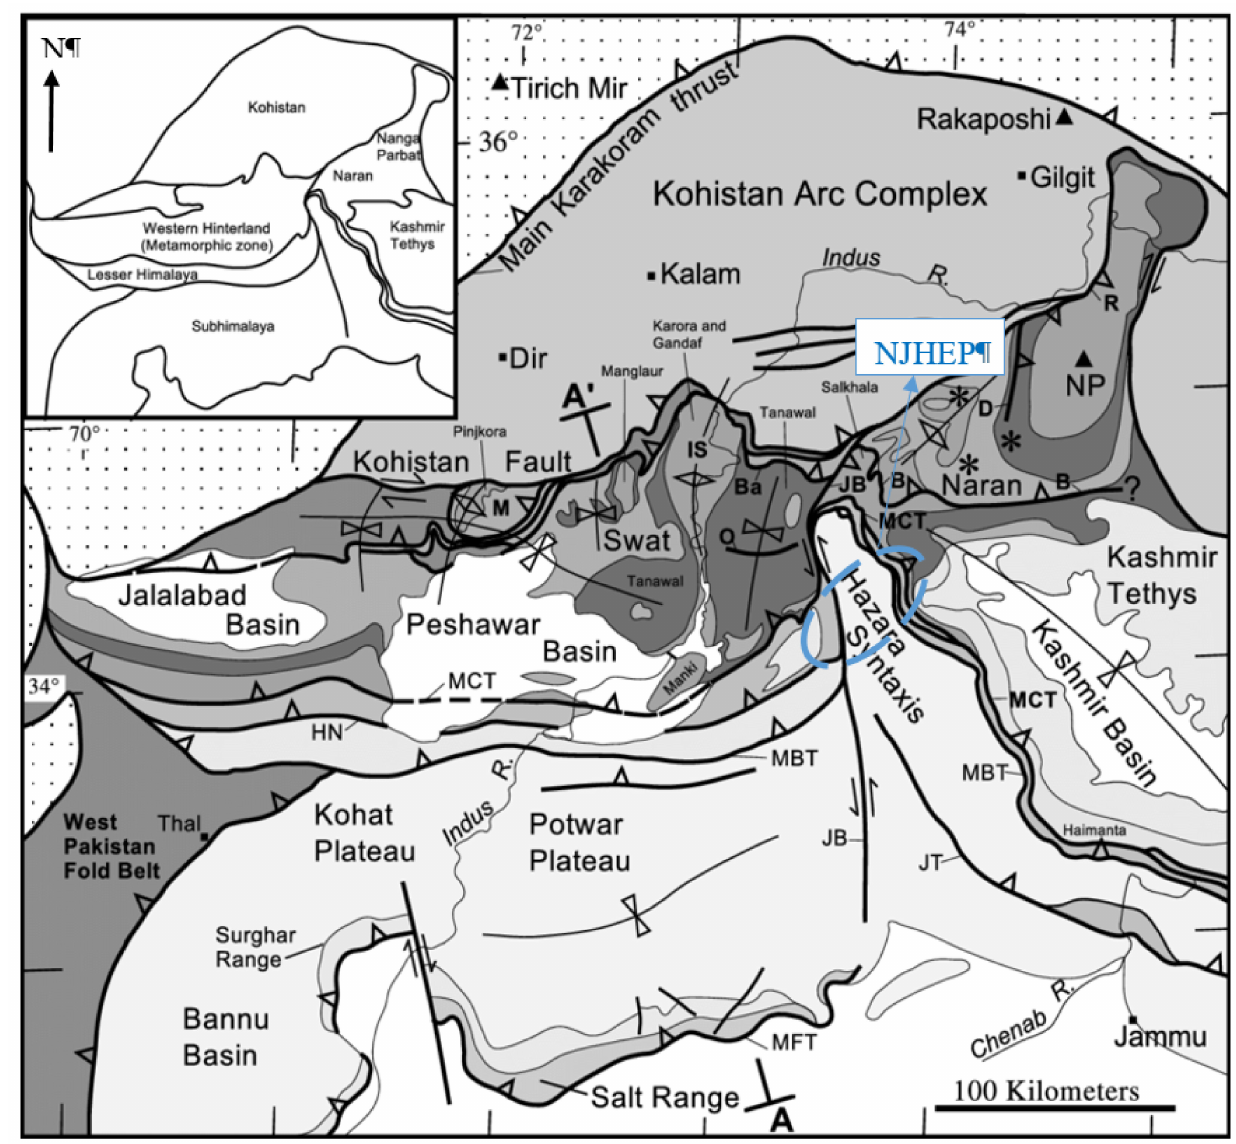
Figure 3. Neelum–Jhelum Hydroelectric Project located in the complex geological environment of the Sub-Himalayan